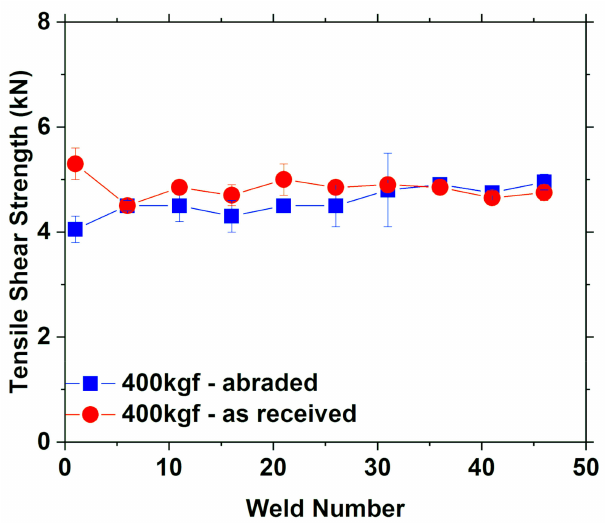
Figure 9. Measured tensile shear strength during continuous RSW under the electrode force of 400 kgf.